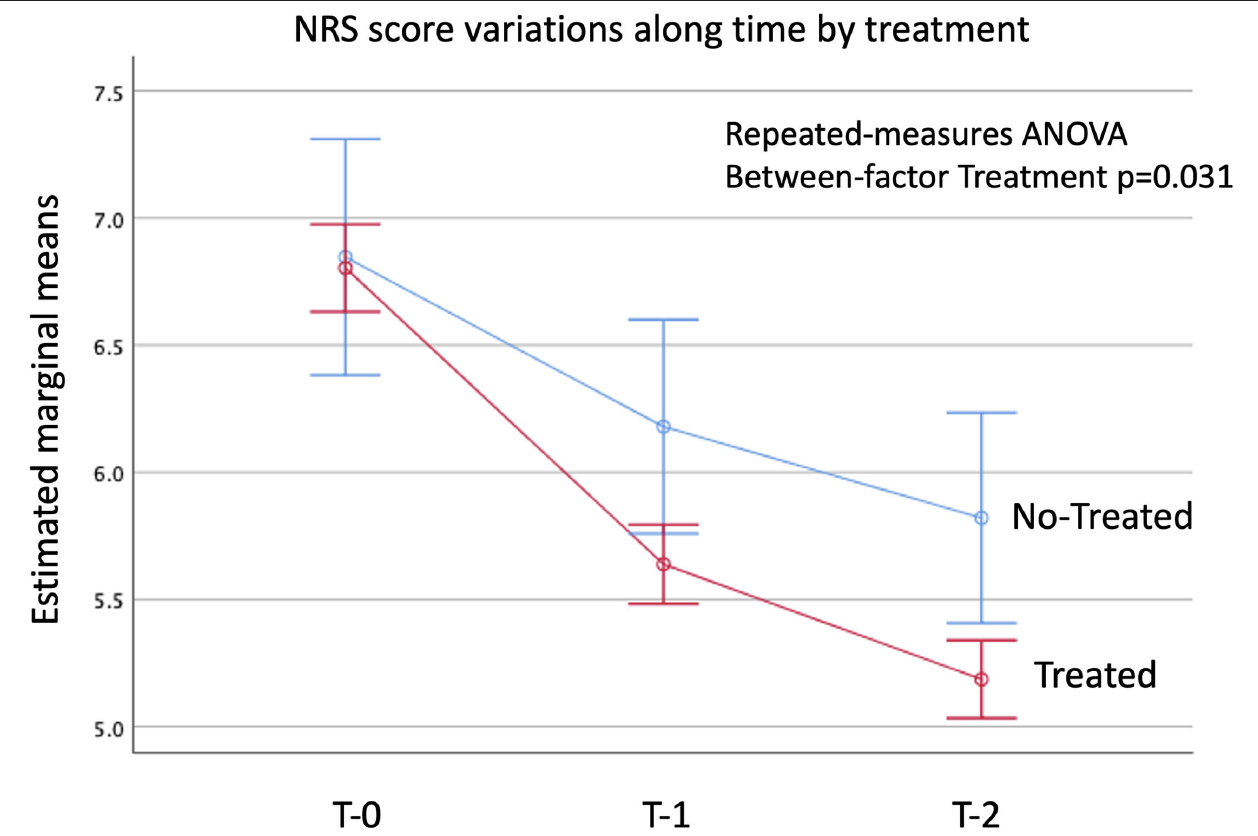
FIGURE 2 | Estimated marginal means of the NRS-score at T0, T1, and T2. Vertical bars denote the 95% C.I. of means.